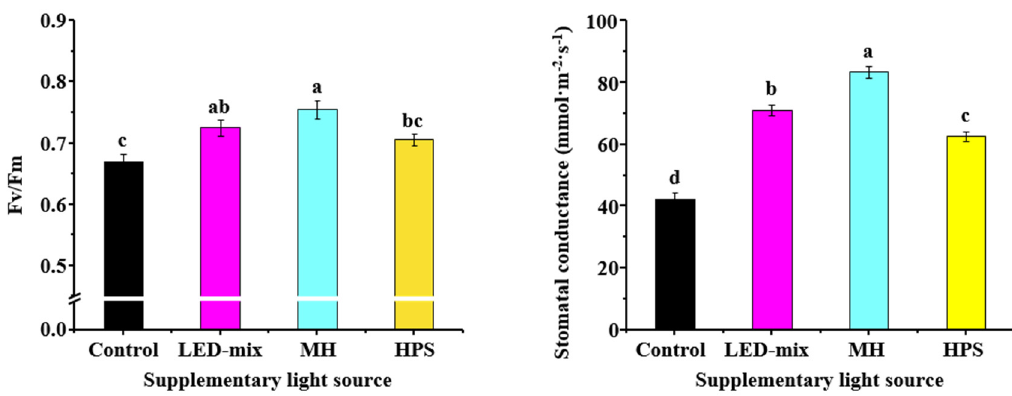
Figure 5. Effect of the supplementary light source on the quantum yield (Fv/Fm) and the stomatal conductance of carnation ‘Dreambyul’. Data are shown as mean ± SEs, and different letters on the bars indicate significant differences according to the Duncan’s multiple range test at p ≤ 0.05.